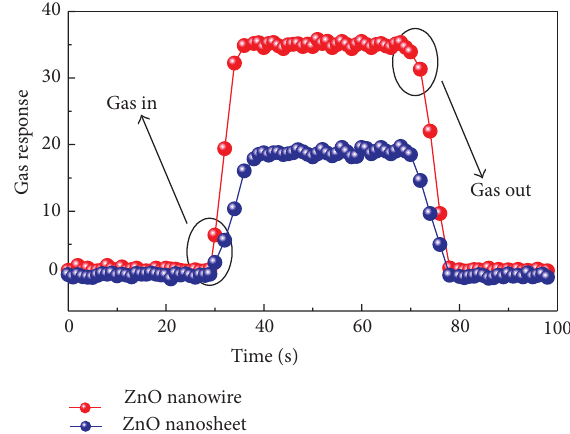
Figure 7: Response transients of the sensors to 20 𝜇 L/L of C 2 H 2 at 550 K.